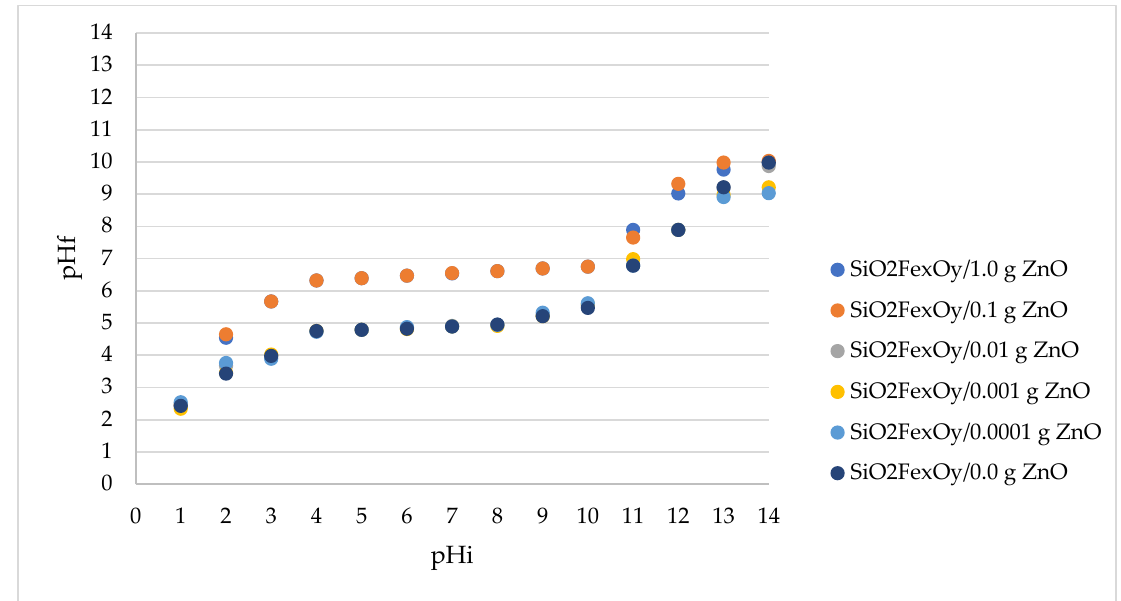
Figure 4. pH pZc of materials.